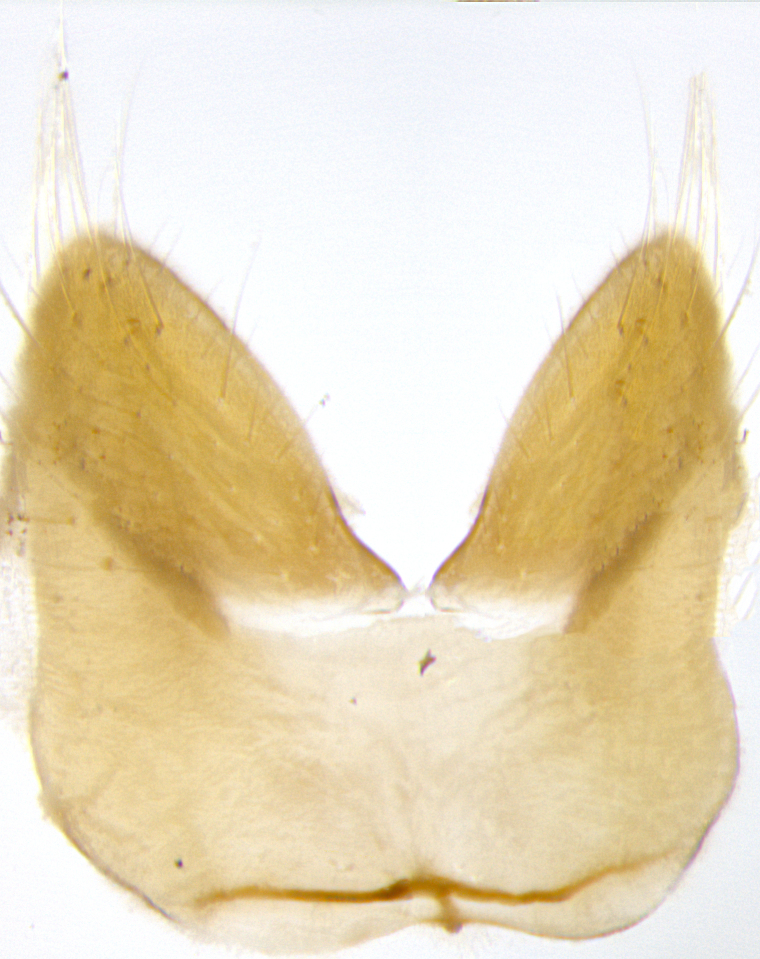
sternite 5, ventral view.